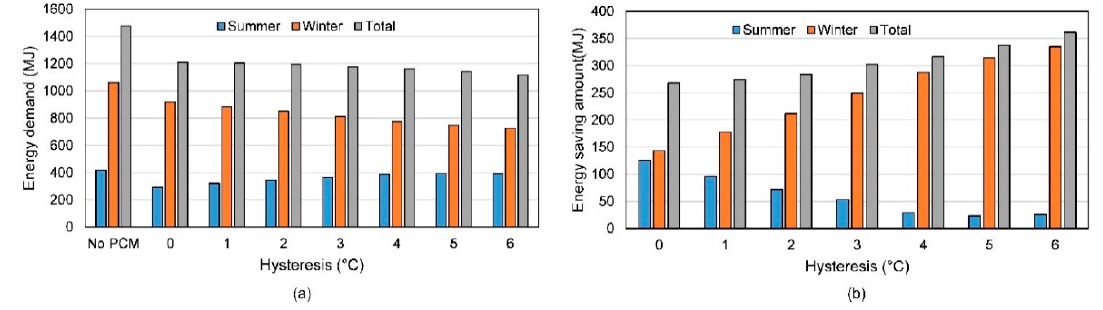
Figure 12. The influence of PCM hysteresis on the building’s energy for severe summer and winter seasons: ( a ) the heat pump’s energy demand; ( b ) the energy savings compared to no PCM.